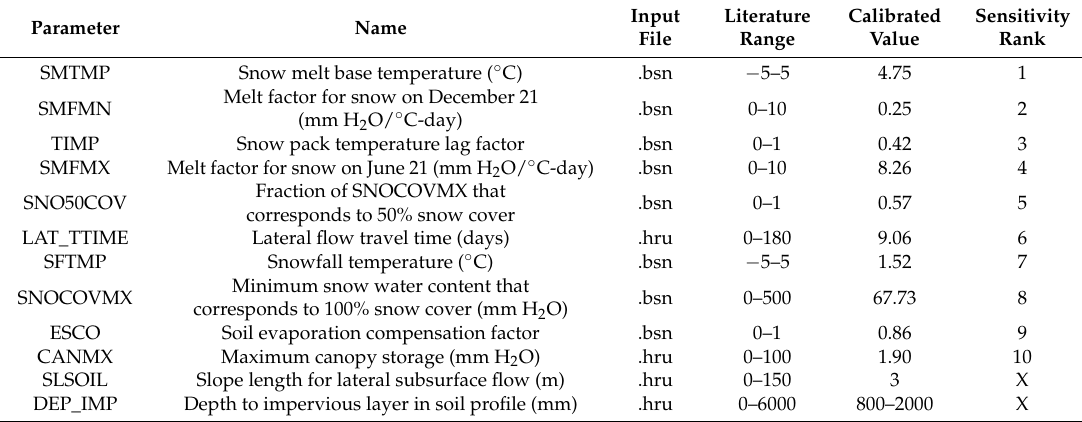
Table 4 gives calibrated and validated parameters values ranked by sensitivity. Table 4. Calibrated values of SWAT parameters. The SLSOIL and the DEP_IMP parameters have not been integrated in the SWAT CUP runs because of their high sensitivity. Because their modification disrupt completely the water flows distribution, we have decided to keep them